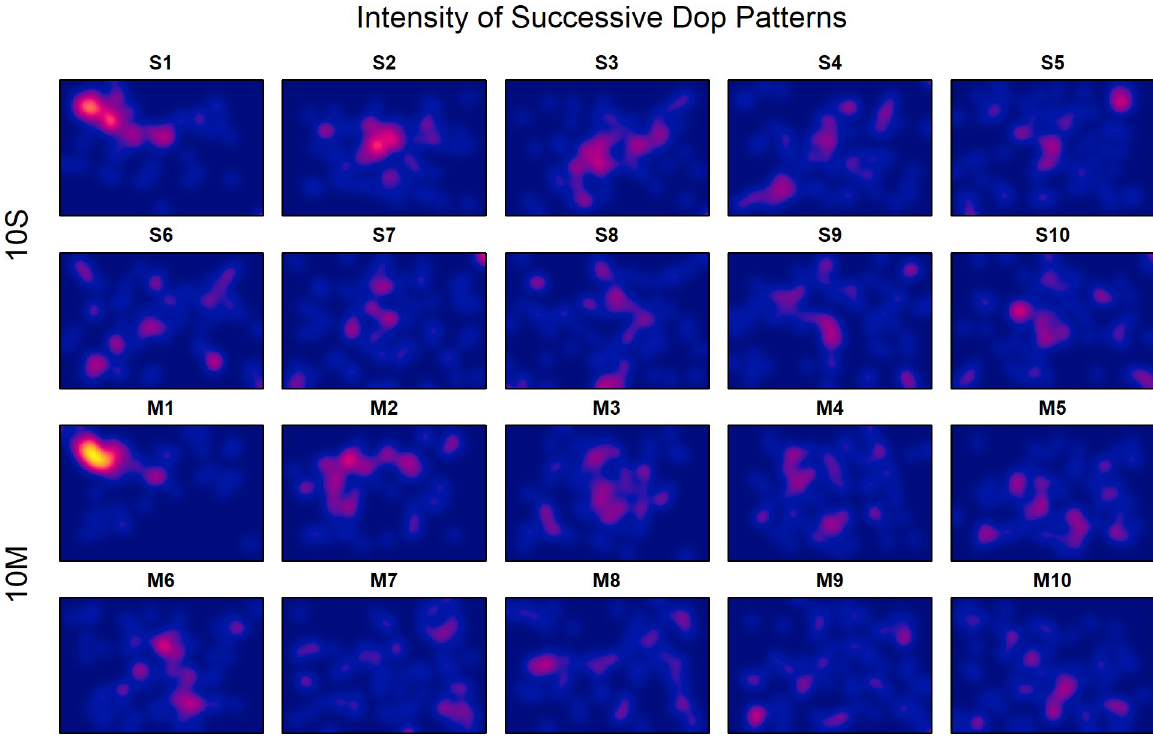
Fig 12. Experiment 3: Intensity plots of the ten successive dot patterns superposed across participants for conditions 10S and 10M, respectively.